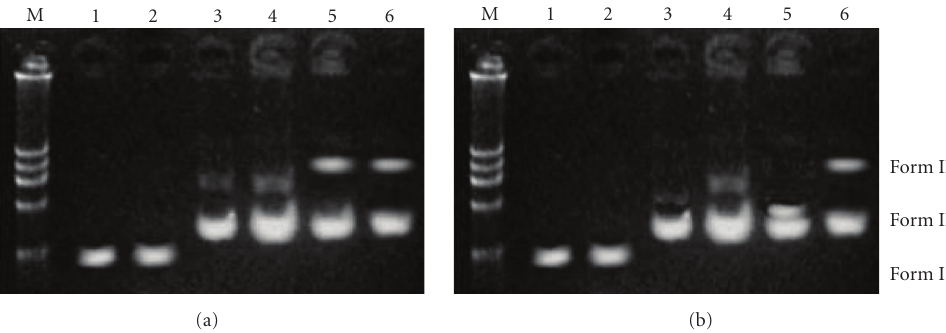
Figure 3: Cleavage of supercoiled pUC19 DNA (0.5 μ g) by the ligands and complexes (a) 1 and (b) 3 in a bu ff er containing 50mM Tris-HCl at 37 ◦ C (30min). lane M: marker; lane 1: DNA control; lane 2: L 1 (10 − 3 M) + DNA; lane 3: DNA + H 2 O 2 ; lane 4: L 2 + DNA + H 2 O 2 ; lane 5: complex (10 − 3 M) + DNA; lane 6: complex + DNA + H 2 O 2